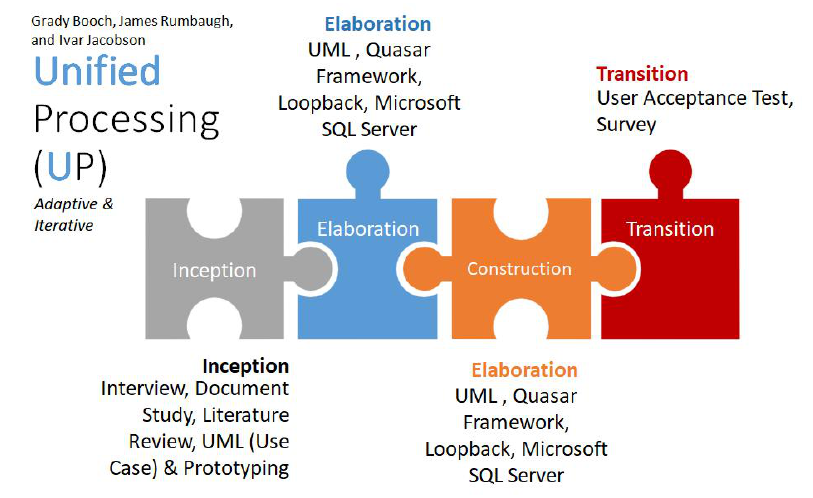
Fig. 1. Process Steps and Methods Used